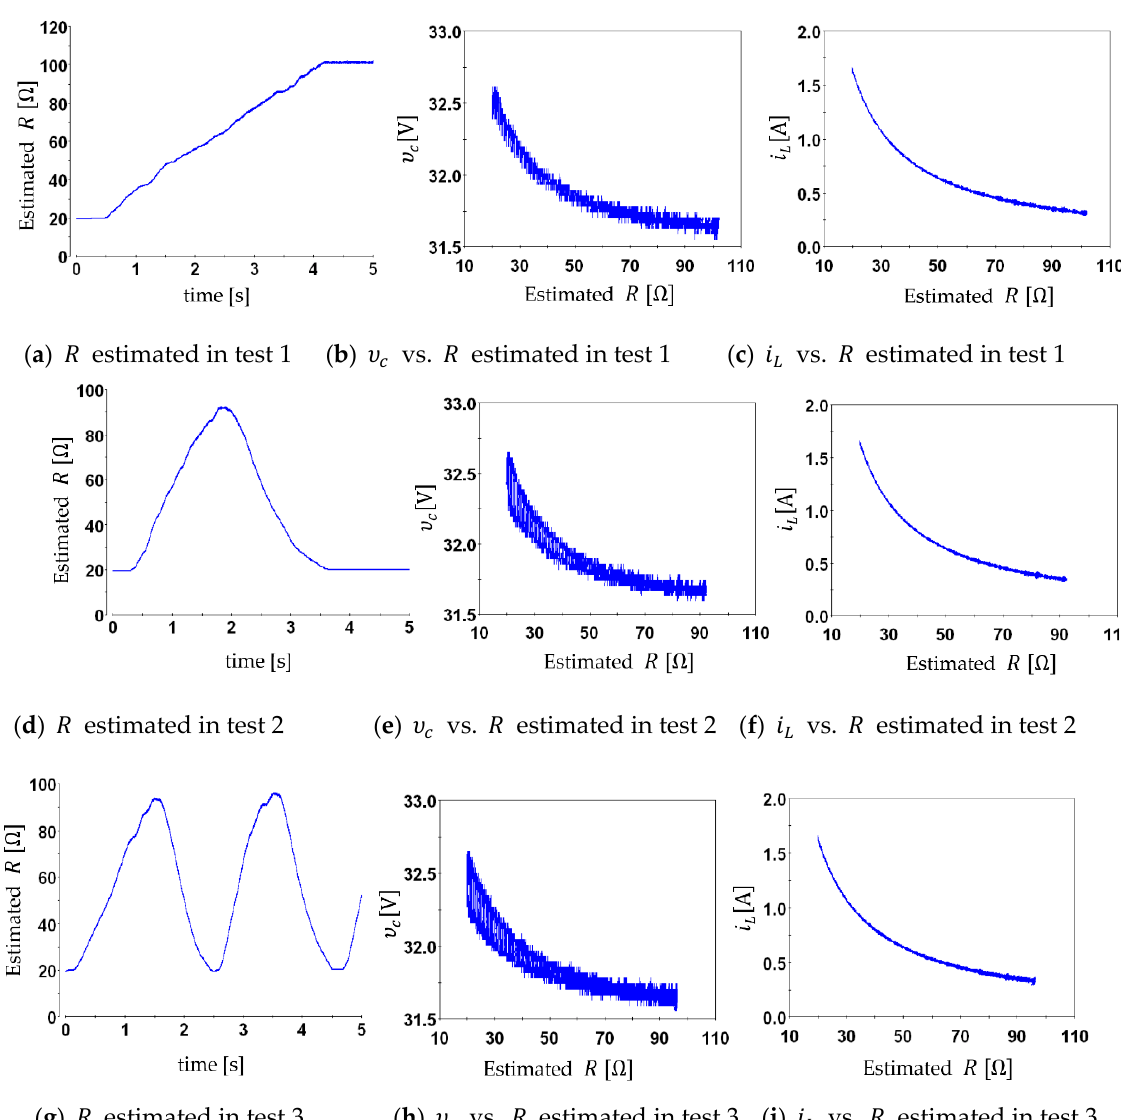
Figure 16. Behavior of the load estimator load R in the experimental test when the load changes for the buck converter controlled with ZAD-FPIC, with one-delay period, K s = 5, N = 1, and γ = 1.